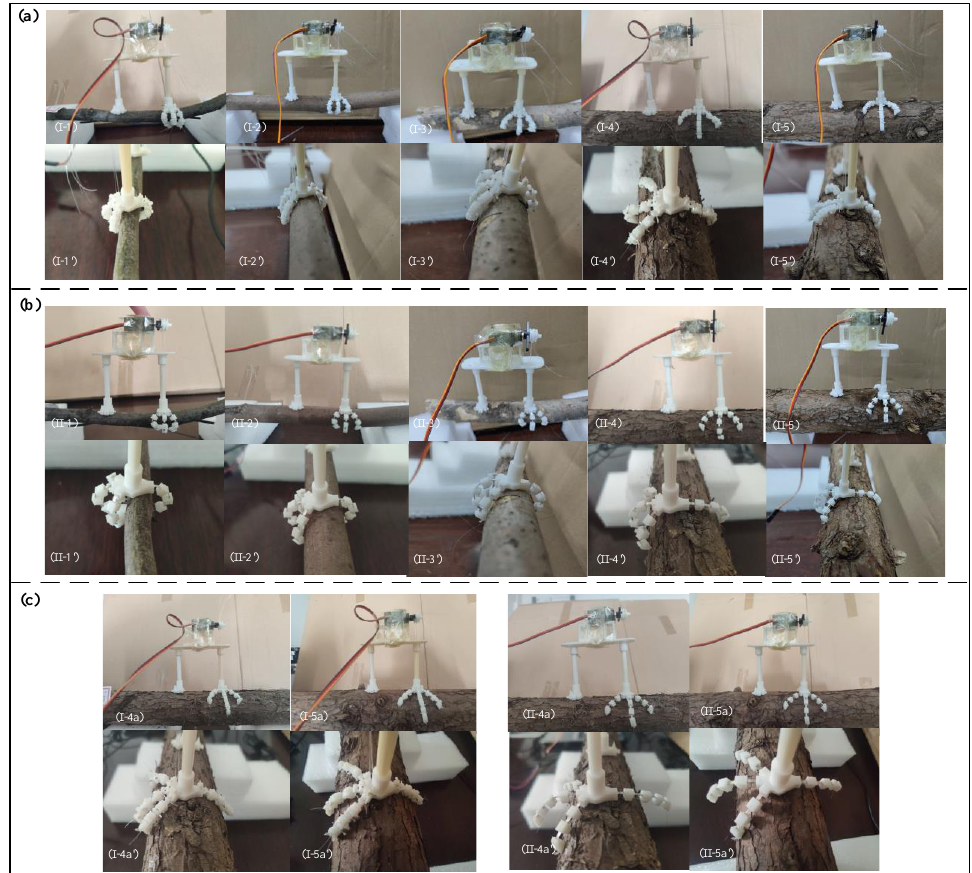
Figure 9. Experiment results of two types of perch gripping mechanism for grasping